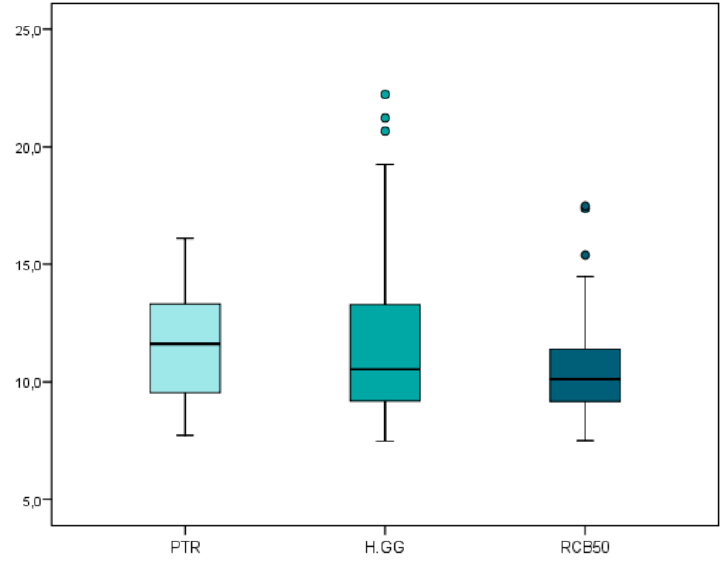
Figure 2. Box plot of the carrier-based root canal filling material volume (mm 3 ) regarding the non-surgical endodontic retreatment techniques. PTR: ProTaper Retreatment endodontic rotary instruments; RCB50: Reciproc Blue endodontic reciprocating instrument; H-GG: combined root canal retreatment technique between Gates-Glidden drills and Hedstrom files.